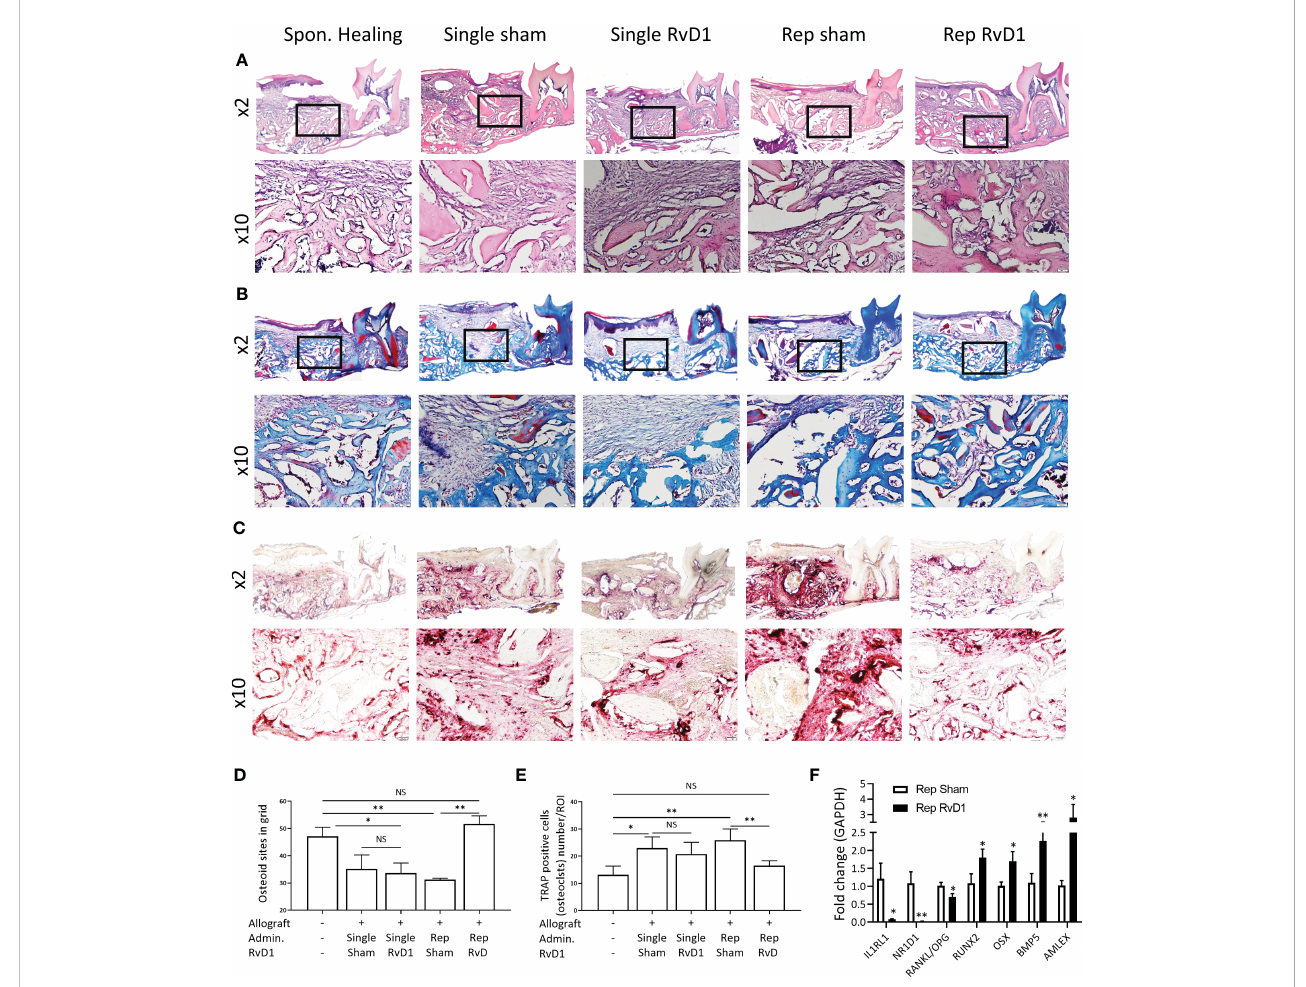
FIGURE 3 Rep-RvD1 increased osteoid apposition and decreased osteoclasts. Representative histological images are presented at x2 and x10. (A) Hematoxylin & Eosin staining. (B) Trichrome (Masson) staining. (C) TRAP staining. (D) Numerical evaluation of de-novo osteoid apposition. (E) Numerical evaluation of osteoclasts/ ROI. (F) Fold change of mRNA expression in rep-RvD1 vs. rep-sham bones samples. The asterisk symbol represents a statistical signi fi cance *<0.05; **<